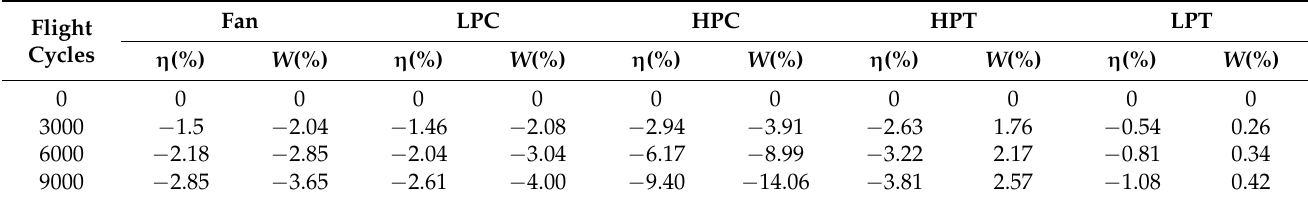
Table 3. Degradation values for health parameters provided from MAPSS